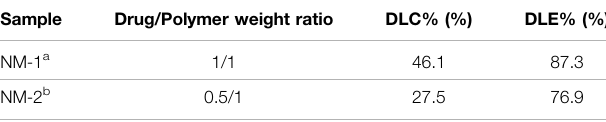
TABLE 2 | DLC and DLE of mPEG-Hz- b -PCL nanomicelles.